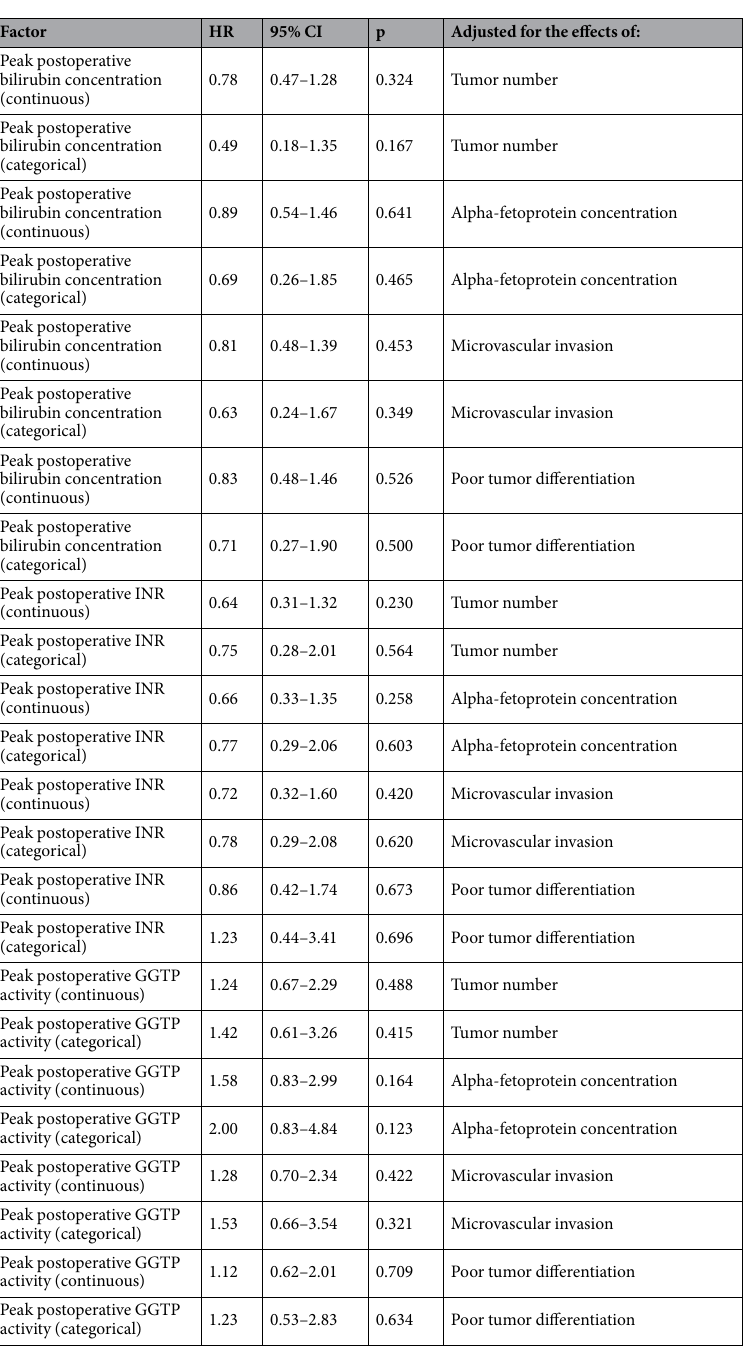
Table 5. Analyses of the associations between peak 7-day postoperative bilirubin concentration, INR value, and GGTP activity and the risk of hepatocellular carcinoma recurrence after liver transplantation adjusted for the confounding influence of independent risk factors. Hazard ratios for continuous variables are given per: 1 mg/ dL increase for bilirubin concentration; 1 increase for INR; 1 log e (U/L) increase for GGTP activity. HR – hazard ratio; 95% CI – 95% confidence interval; INR – international normalized ratio; GGTP – gamma-glutamyl